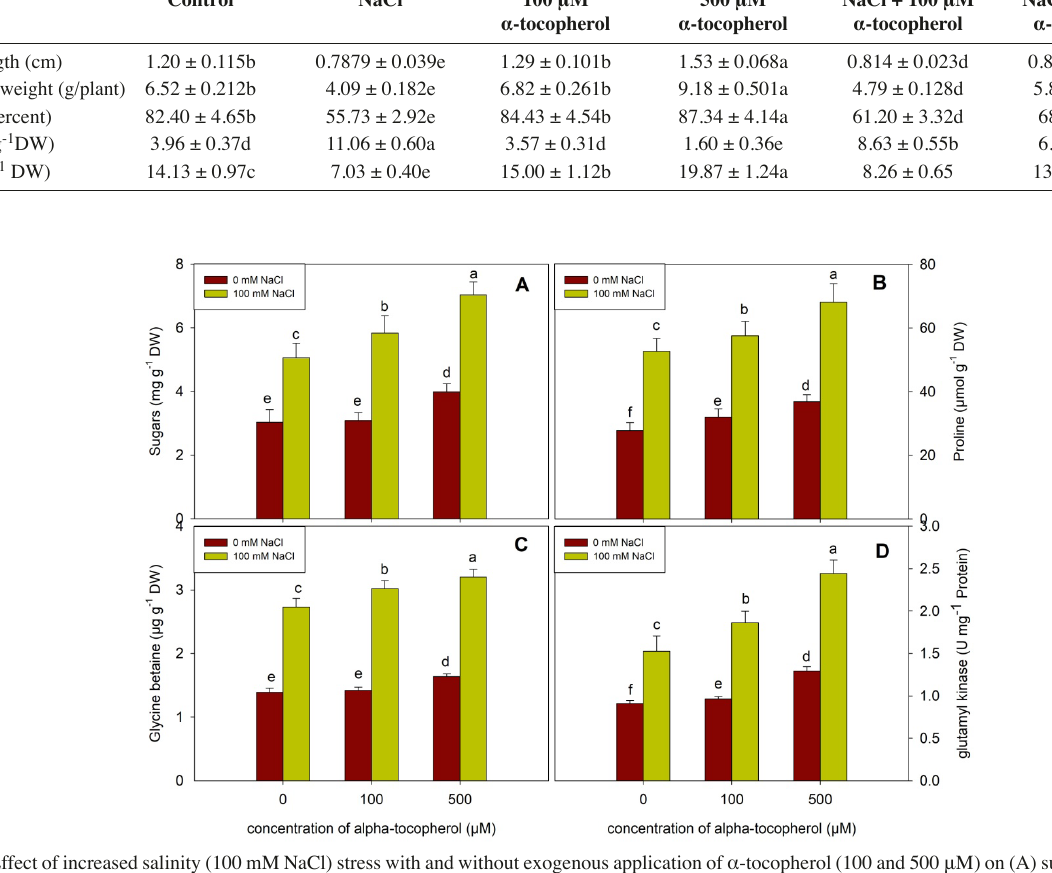
Fig. 1: Effect of increased salinity (100 mM NaCl) stress with and without exogenous application of α-tocopherol (100 and 500 μM) on (A) sugars, (B) proline, (C) glycine betaine and (D) γ -glutamyl kinase activity in soybean ( Glycine max ). Values are mean (±SE) of five replicates and different letters represent significant difference at